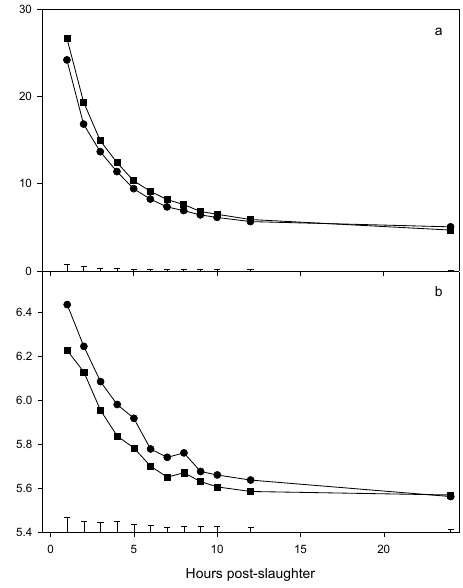
Fig. 1. Mean temperature (a) and pH (b) profiles in M. lon- gissimus from the fallow deer from two treatments (● pasture raised and ■ barley/hay-fed, n =12 in each group) included in the study, measured at 1, 2, 3, 4, 5, 6, 7, 8, 9, 10, 12 and 24 h post-mortem , with error bars indicating standard errors of difference (S. E. D.).